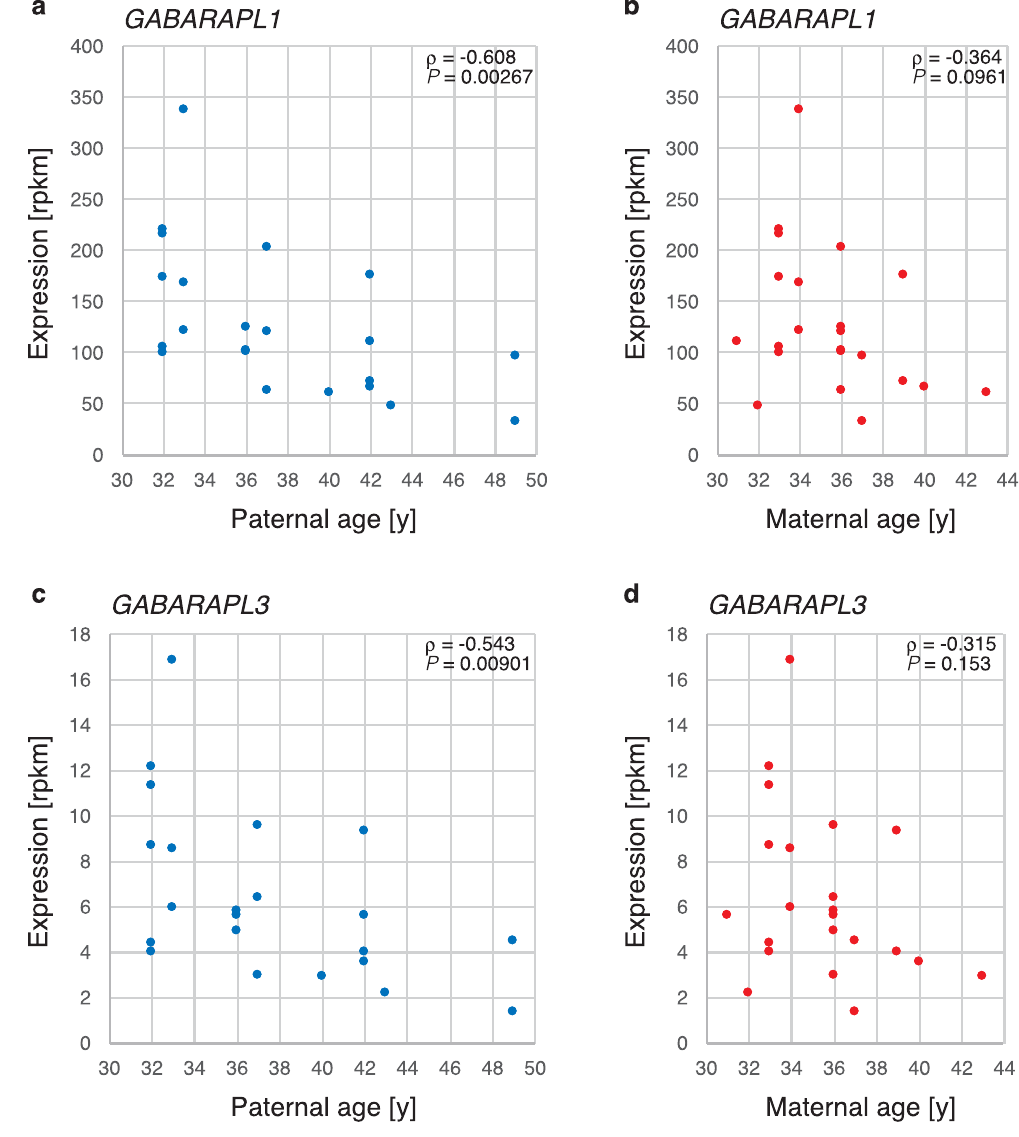
Figure 4. GABARAPL1 and GABARAPL2 expression according to parental age. GABARAPL1 expression levels were plotted against the maternal age ( a ) or paternal age ( b ), and GABARAPL3 expression levels were plotted against the maternal age ( c ) or paternal age ( d